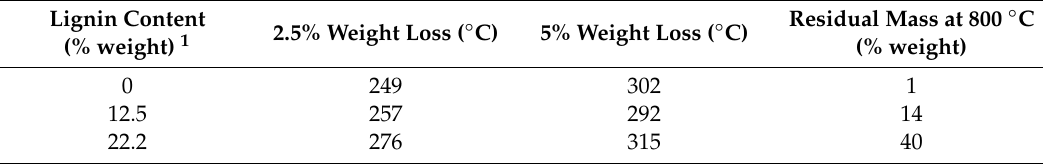
Table 4. Thermal decomposition data from the TGA curves.